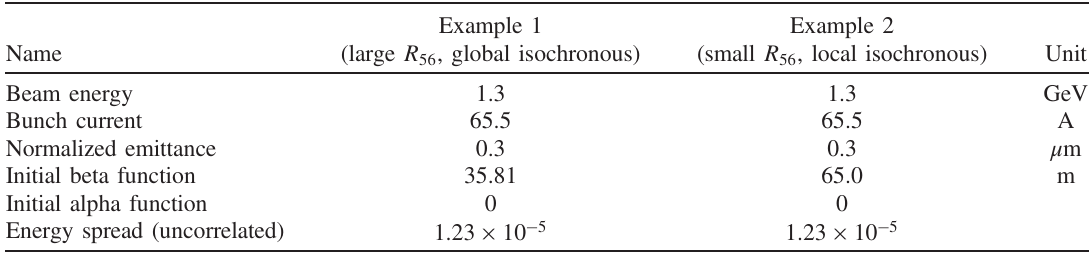
TABLE I. Initial beam and Twiss parameters for Example 1 and Example 2 arc lattices.